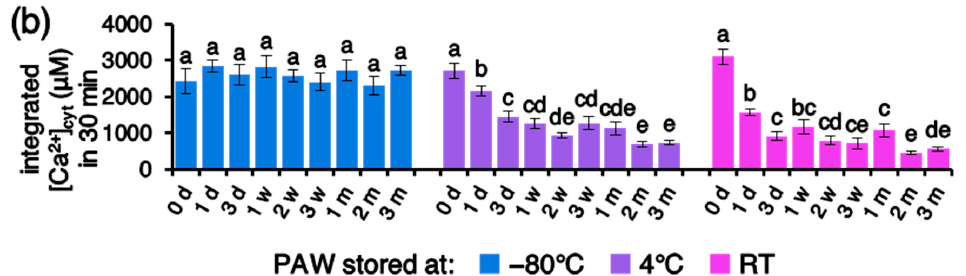
Figure 4. ( a ) Effects of different temperatures and time intervals of PAW storage on PAW-induced [Ca 2+ ] cyt increases. Ca 2+ measurement assays were conducted in aequorin-expressing Arabidopsis seedlings. Seedlings were challenged with 1:4 dilutions of PAW generated by exposing deionized H 2 O to cold plasma for 5 min at 900 W torch #1 power. Upon production, PAW was stored at different temperatures prior to plant treatment: − 80 °C (blue), 4 °C (purple), and room temperature (RT) (pink) for various time intervals (ranging from 0 days up to 3 months), as indicated on top of the panels. Data are the means (solid lines) ± SE (shading) of six seedlings derived from three independent growth replicates. Arrowheads indicate the time of stimulus application (at 100 s); ( b ) statistical analyses of integrated [Ca 2+ ] cyt dynamics over 30 min are shown. Key: d, days; w, weeks; and m, months. Bars labelled with different letters differ significantly ( p < 0.05, Student’s t test).